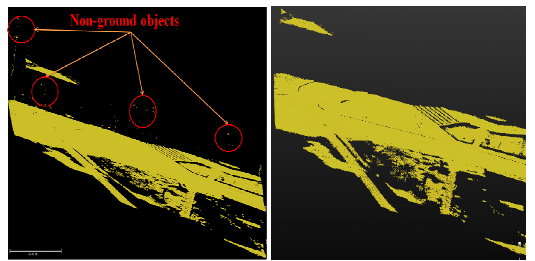
Figure 8. Segmentation results of third phase. Left: Unrefined ground segment. Right: Refined ground segment.